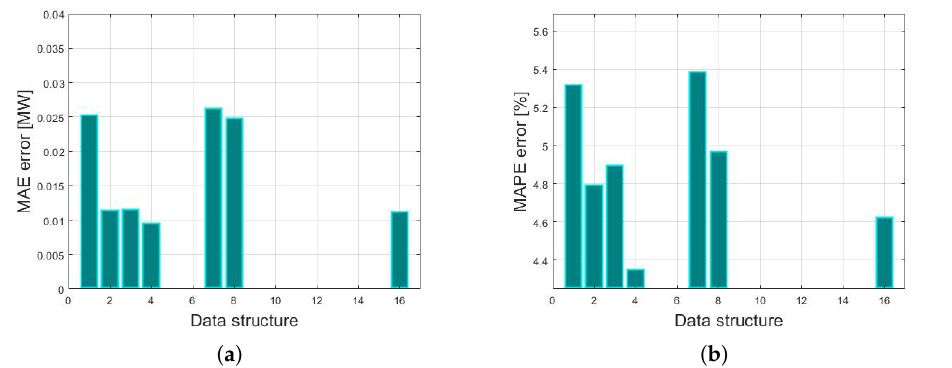
Figure 28. Summary of forecast accuracies by the selected data structure for wind power plant FW4. ( a ) MAE. ( b )